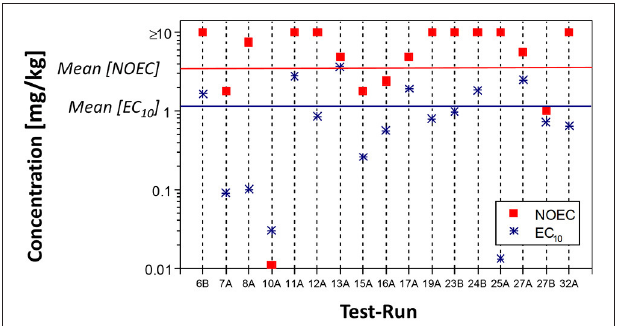
FIGURE 1 | Mean number of juveniles, presented as NOEC or EC10, of E. albidus in 17 different ringtest runs from 16 different laboratories, indicated here bei the codes on the x-axis (Römbke, 2003). Note that results were obtained in tests following either a NOEC design or ECx design (for details see Römbke and Moser,